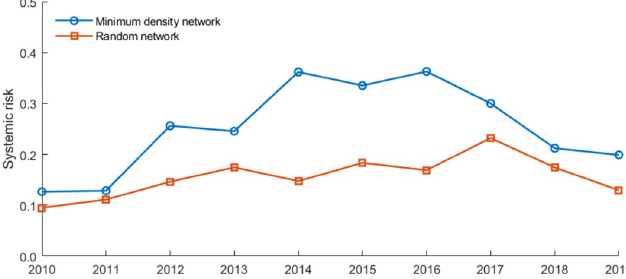
Fig 4. Overall systemic risk in banking networks with different matching